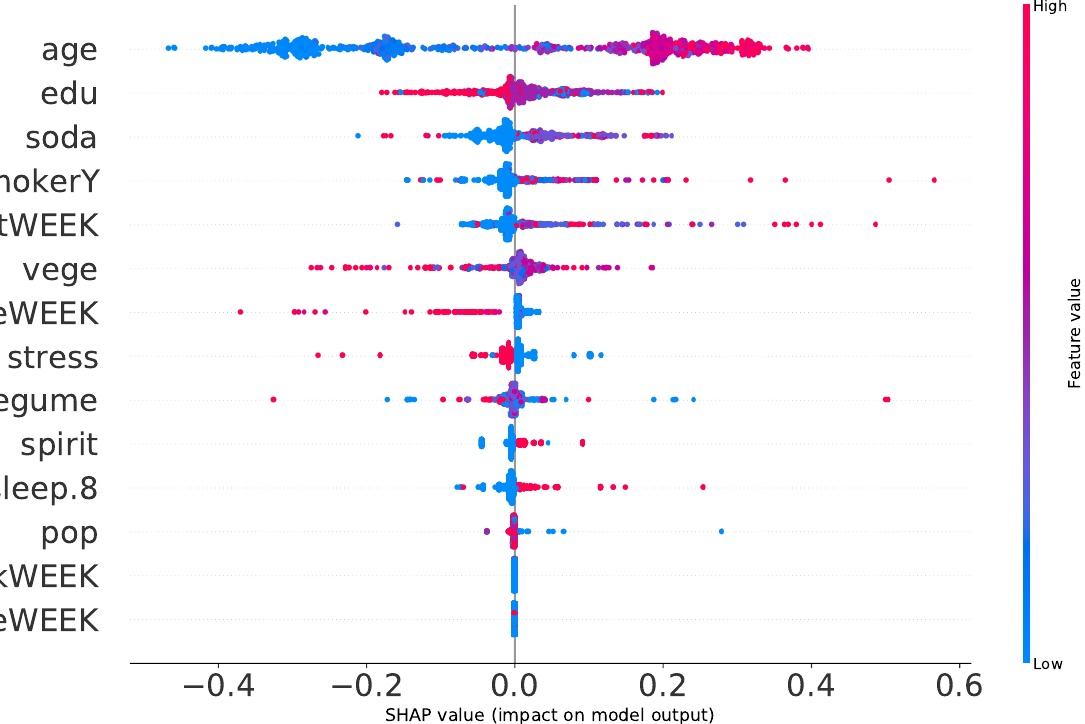
Figure 10. Impact of Variables with SHAP, Decision Tree with Stud Selection, without